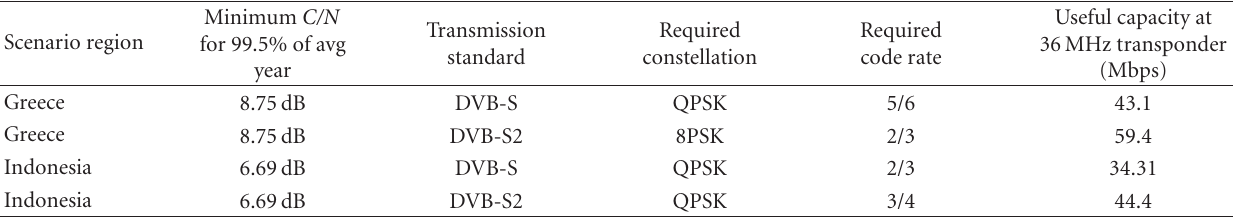
Table 4: Broadcasting with static transmission in the two scenarios; parameters used and overall capacity for 99.5% required link availability.